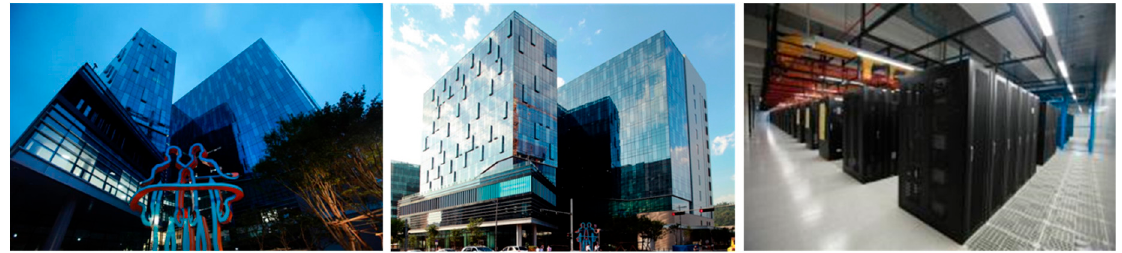
Figure 6. Reference data center of the case study.